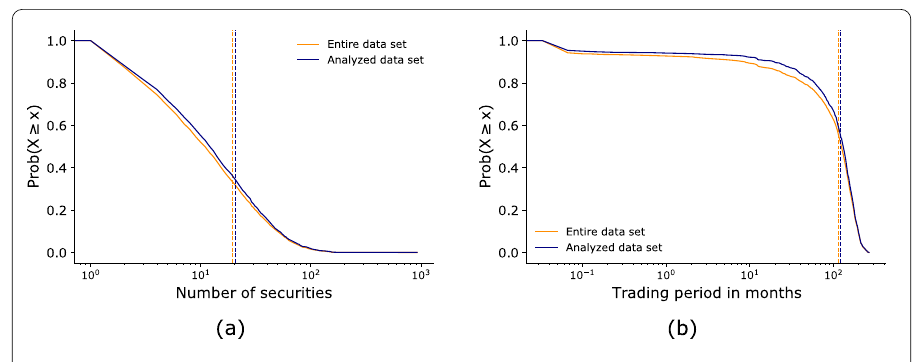
Figure 12 Trading statistics for 1656 insiders that have traded in the HSE. ( a ) The number of the unique traded securities by insiders. ( b ) The length of trading activity period by insiders in months. The dashed vertical line marks the average